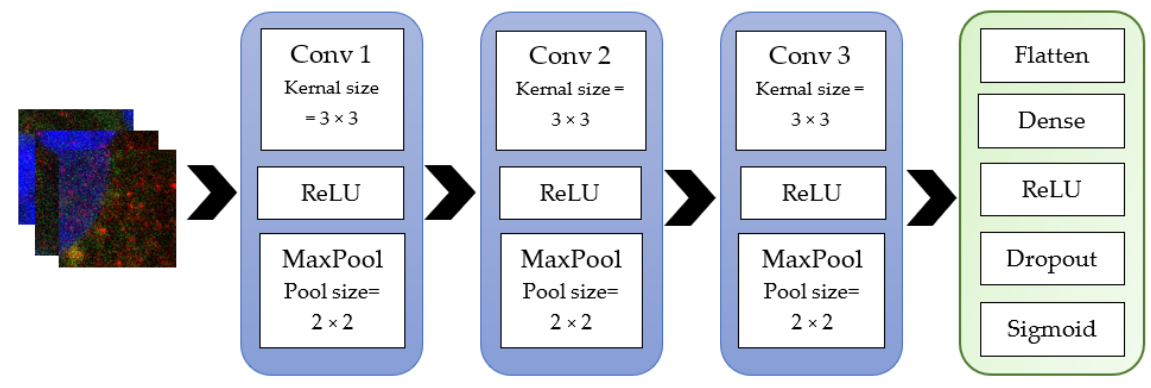
Figure 9. Model 2- sequential model’s layers. Figure 9. Model 2-sequential model’s